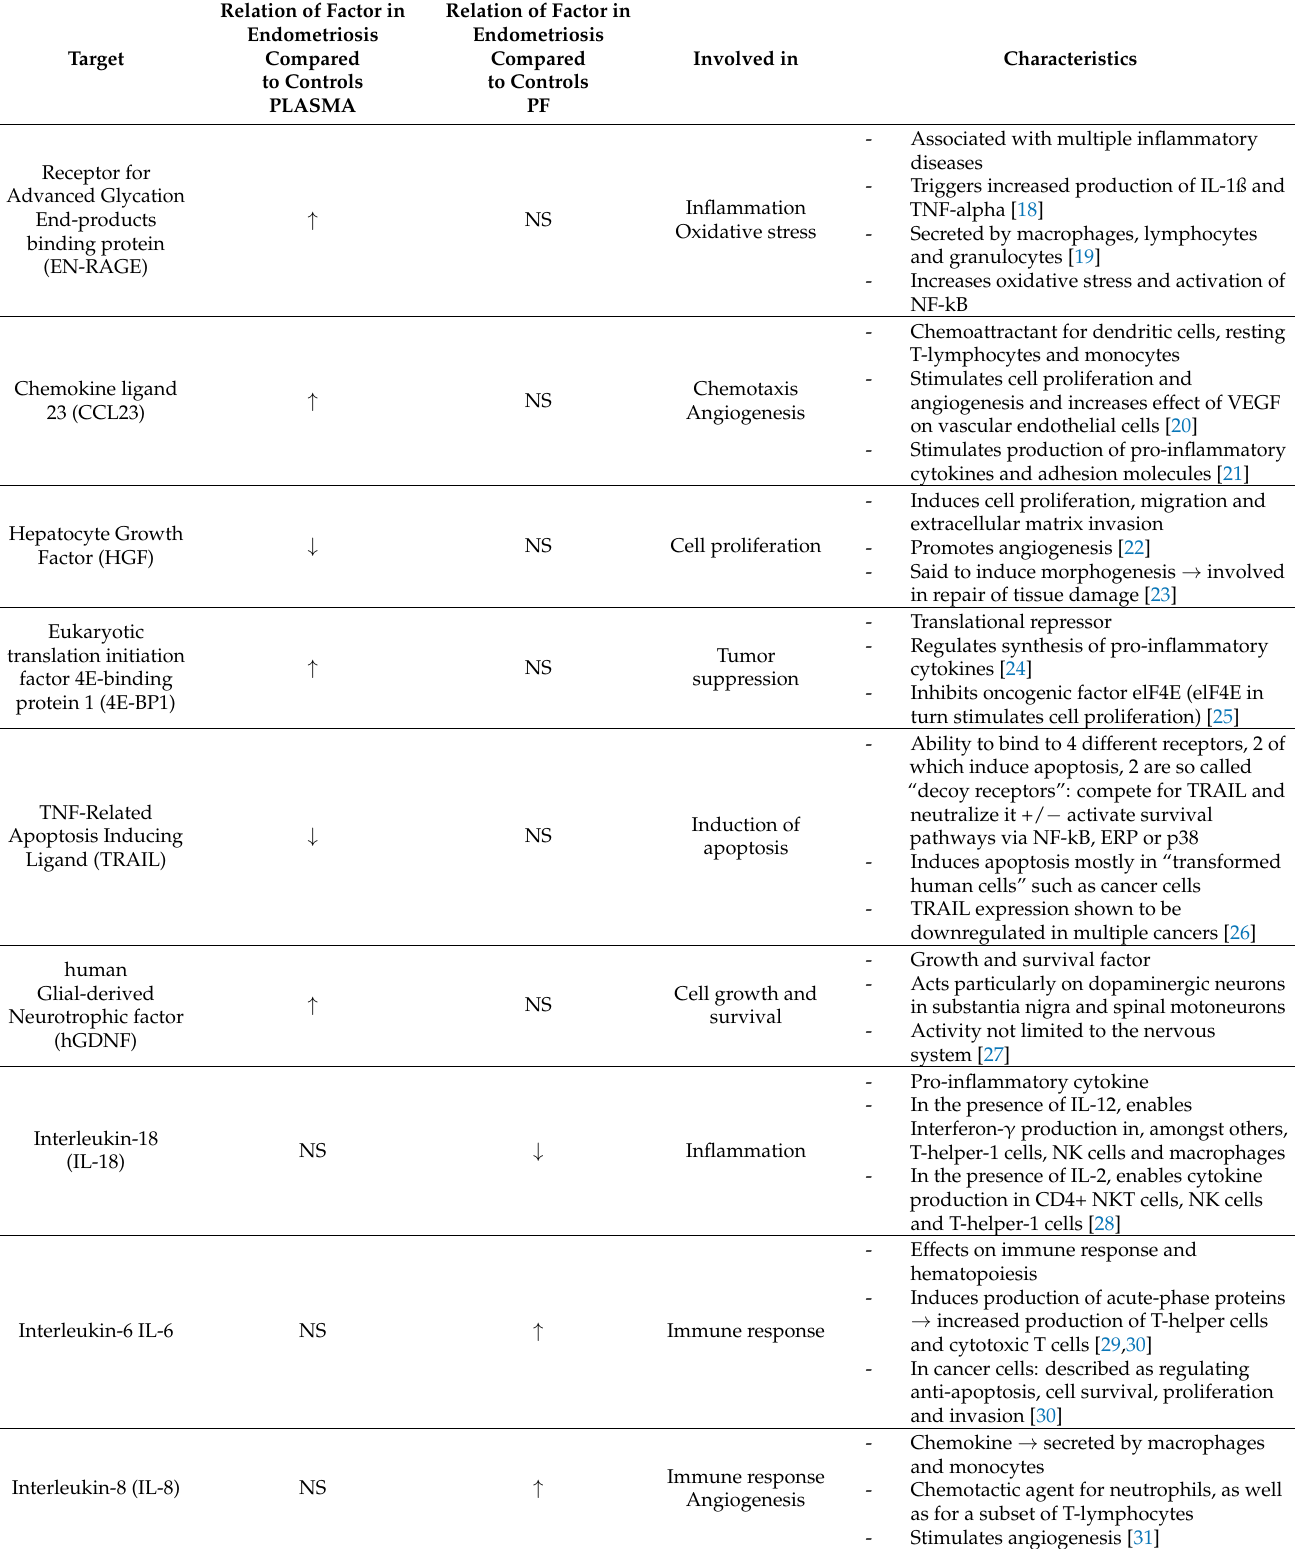
Table legend— ↑ : increased, ↓ : decreased, NS: not significant, PF: peritoneal fluid, IL-1ß: Interleukin-1ß, TNF- alpha: Tumor Necrosis Factor-alpha, NF-kB: Nuclear Factor kappa B, NKT: natural killer T-cells, VEGF: